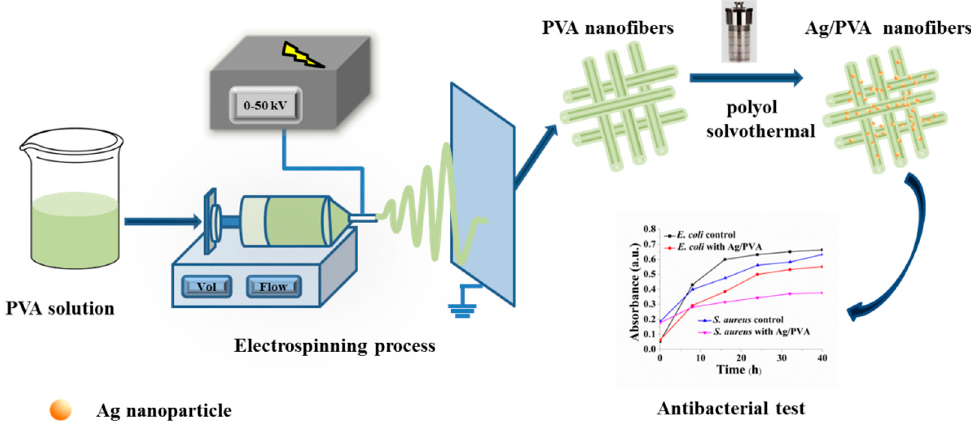
Figure 1. Schematic illustration of fabrication and antibacterial test for Ag / PVA composite nanofibers (CNFs) through the electrospinning and solvothermal methods.